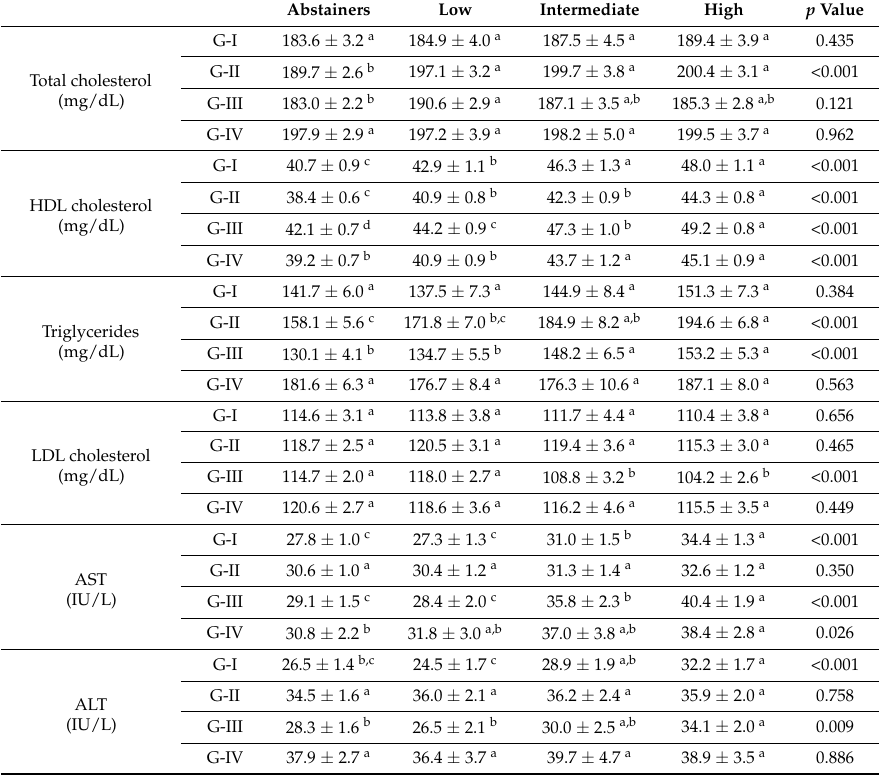
Table 4. Metabolic risk factors by alcohol consumption and β -cell function and insulin sensitivity in